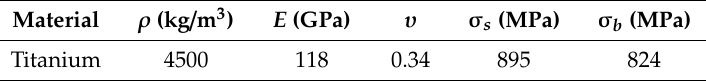
Table 6. Material parameters of titanium.